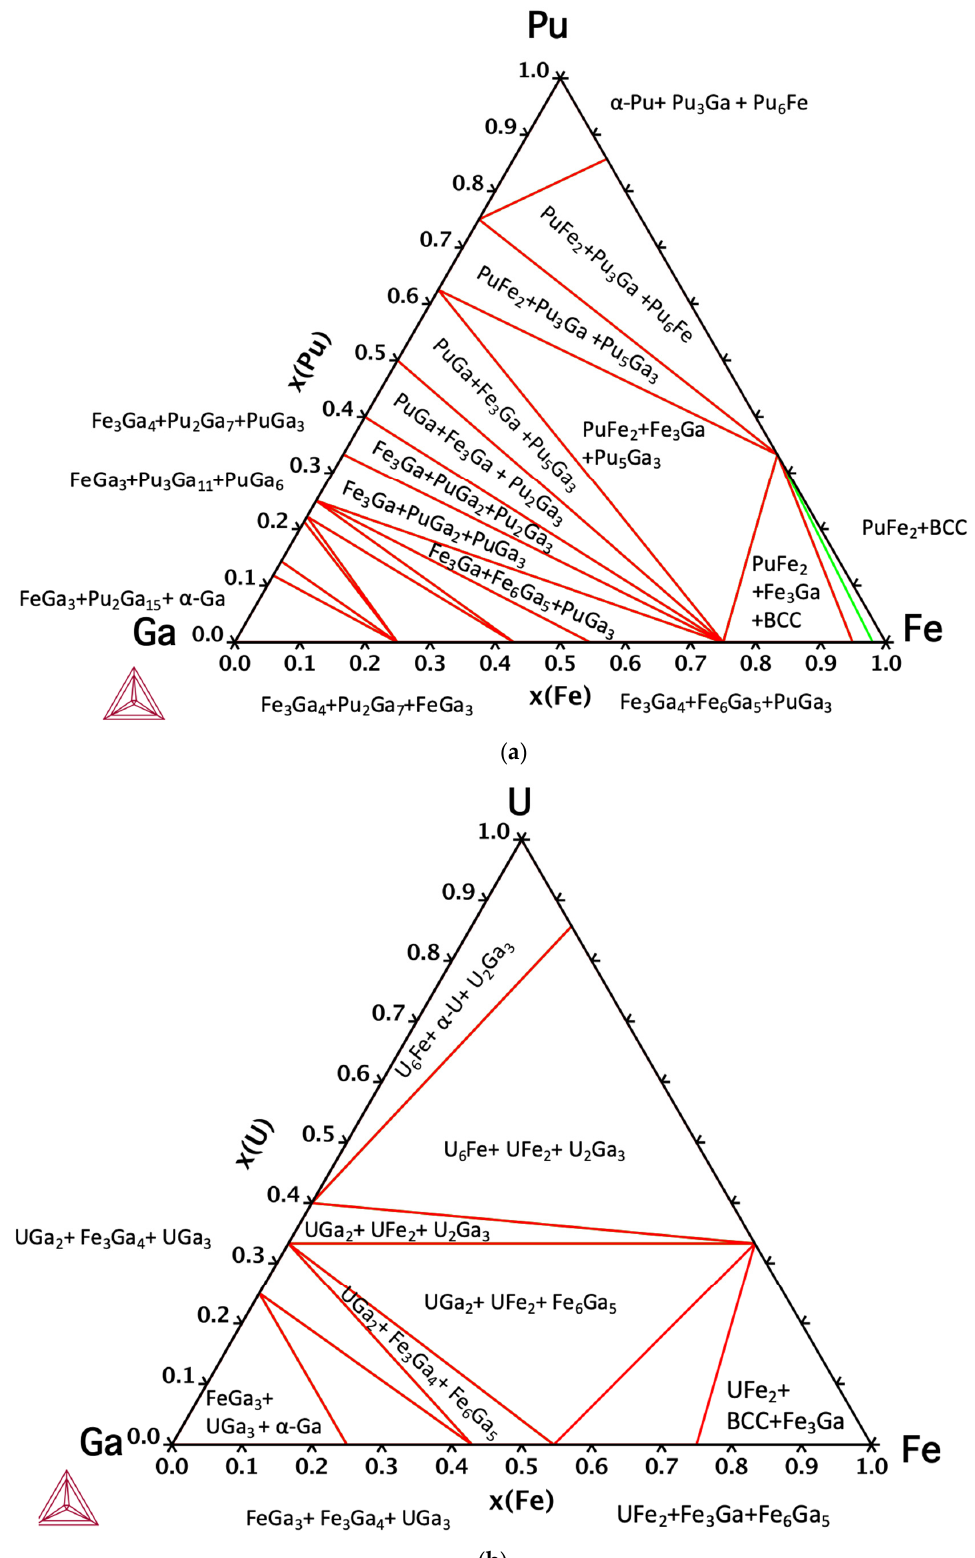
Figure 9. Calculated ( a ) Pu-Fe-Ga and ( b ) U-Fe-Ga ternary sections at room temperature based on the present CALPHAD assessments.